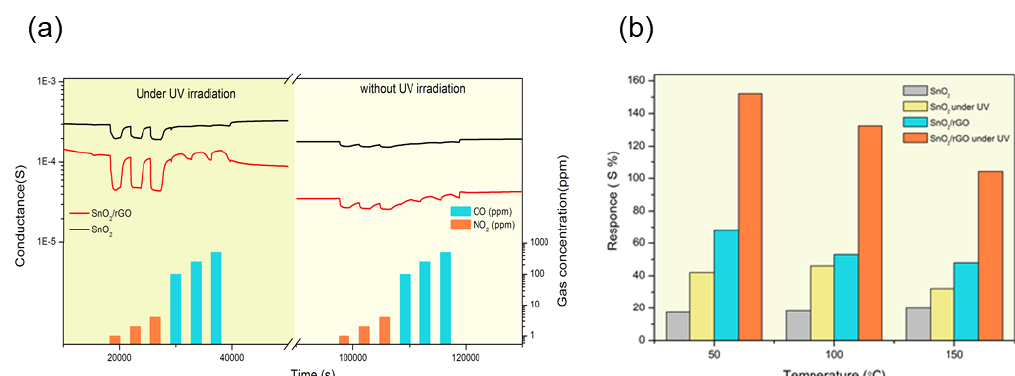
Figure 13. ( a ) Dynamic response of SnO 2 , SnO 2 / rGO composite toward NO 2 (1, 2. 5, 4 ppm), CO (100, 250, 500 ppm) at 50 °C and relative humidity (RH) = 40%. ( b ) Sensor responses toward NO 2 (4 ppm) in different working temperature and RH = 40%. Reproduced with permission [96].